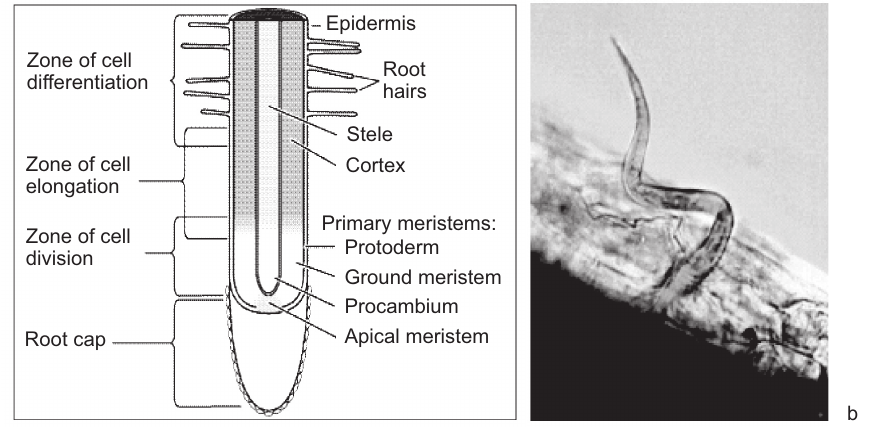
Fig. 2 a & b. – a. Root anatomy: the zone of elongation is prefered site of penetration for sedentary plant para- sitic nematodes and chemical gradients can be used as orientation markers for short distances on the root surface and within the root tissue. b. Photograph showing M. incognita second stage juveniles invading a tomato root at the zone of